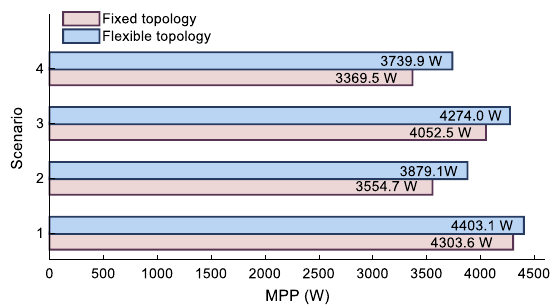
Fig. 15 MPP of the fixed and flexible topologies for SP-based PV array under the four mismatch scenarios